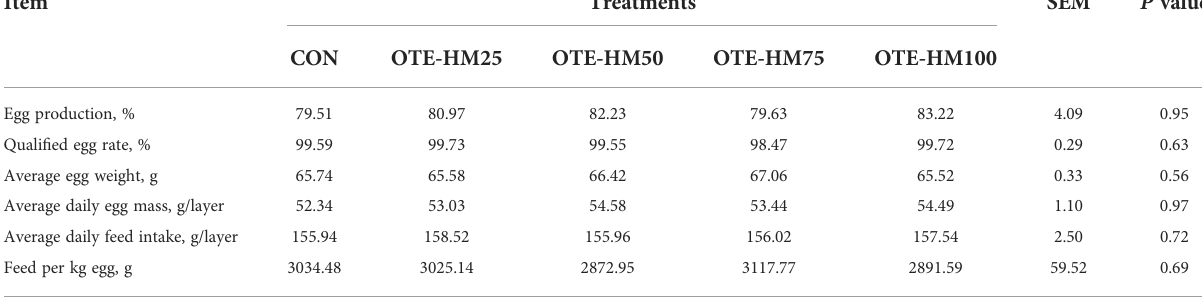
TABLE 2 Effects of experimental diets on laying performance of laying ducks 1